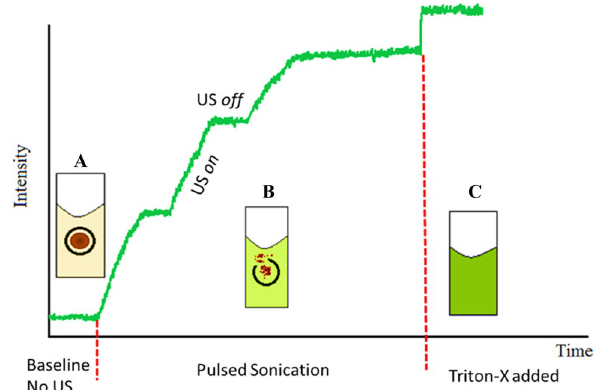
Figure 4. Calcein release from calcein-loaded liposomes following pulsed LFUS sonication. Calcein is self- quenched inside the liposomes showing low initial fluorescence level ( A ). The pulsed LFUS results in calcein release from the liposomes leading to the increase in calcein fluorescence ( B ). The addition of Tx-100 results in the maximum calcein release ( C